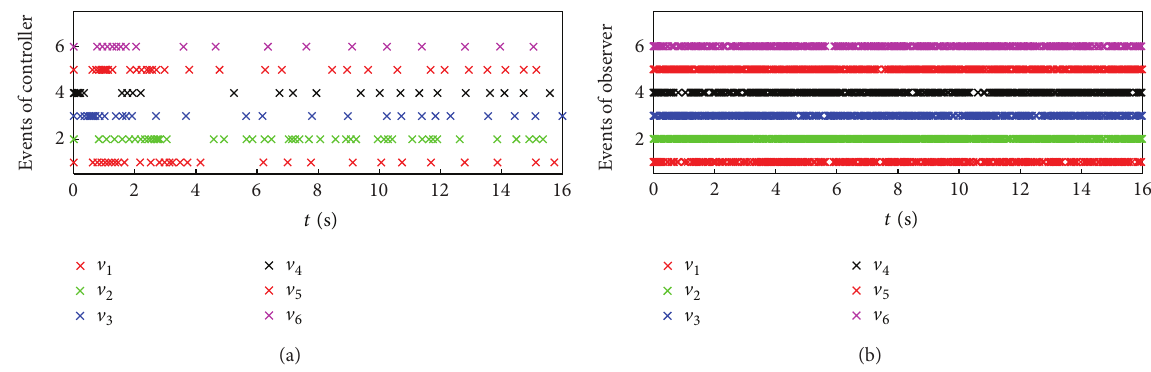
Figure 9: Event-triggering instants of controller and observer of each